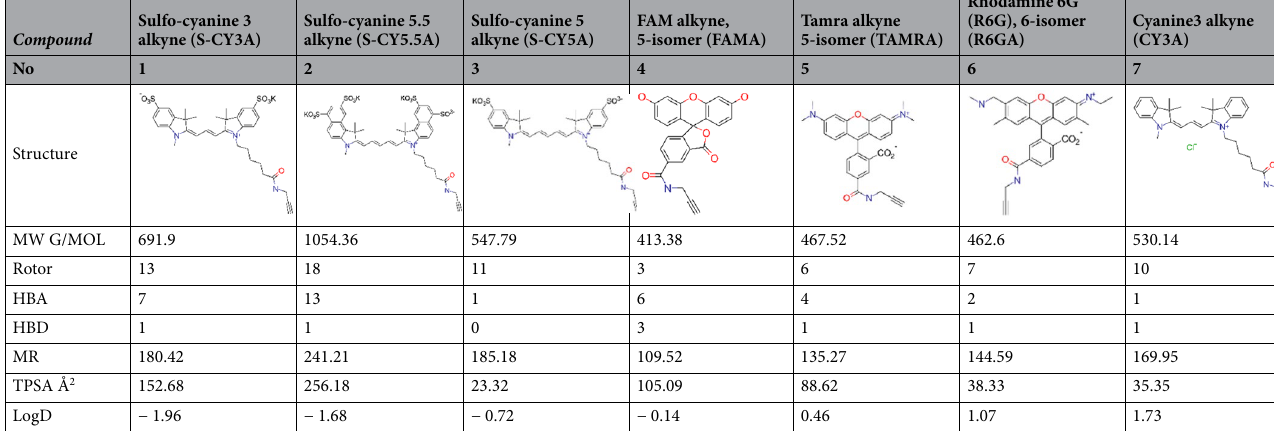
Table 1. Molecular descriptors of the fluorescent compounds ( in-silico analysis using SwissADME) and the experimentally determined LogD